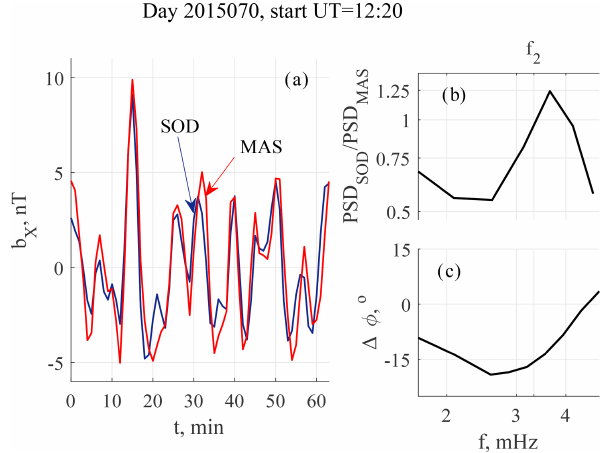
Figure 15. Illustration of FLR signatures of geomagnetic pulsations on 11 March (event 1). Pulsation waveforms at SOD and MAS (a) ; meridional PSD ratio (b) and phase difference (c)